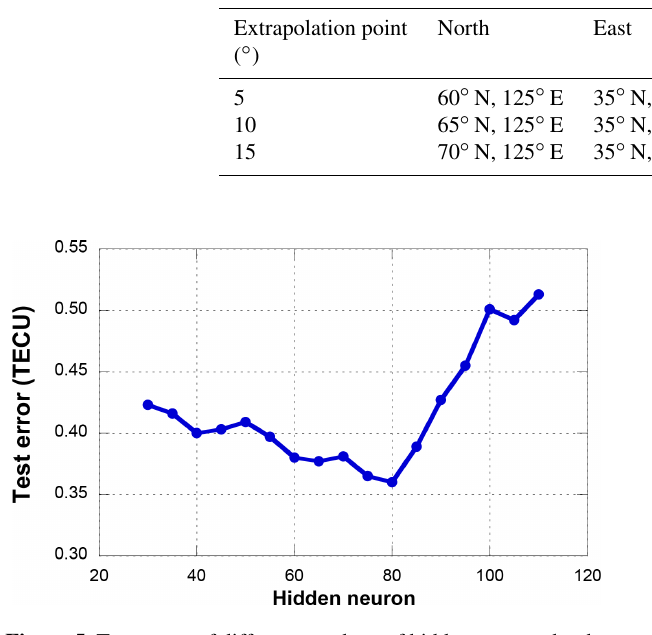
Figure 6. Test errors of different C values by the SVM model (5 ◦ extrapolation